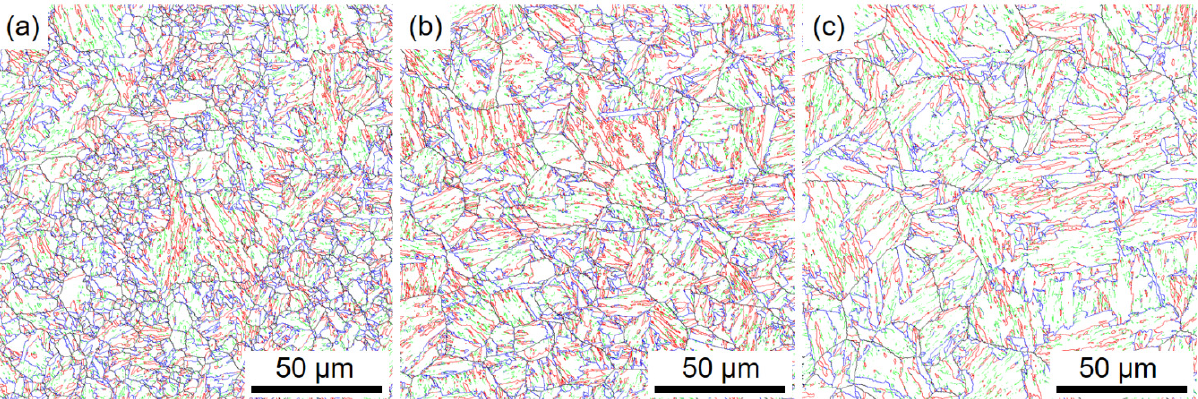
Figure 3. Different types of boundaries (black lines: PAG boundaries, blue lines: packet boundaries, red lines: block boundaries, green lines: sub-block boundaries) of ( a ) Q850, ( b ) Q950 and ( c ) Q1050.